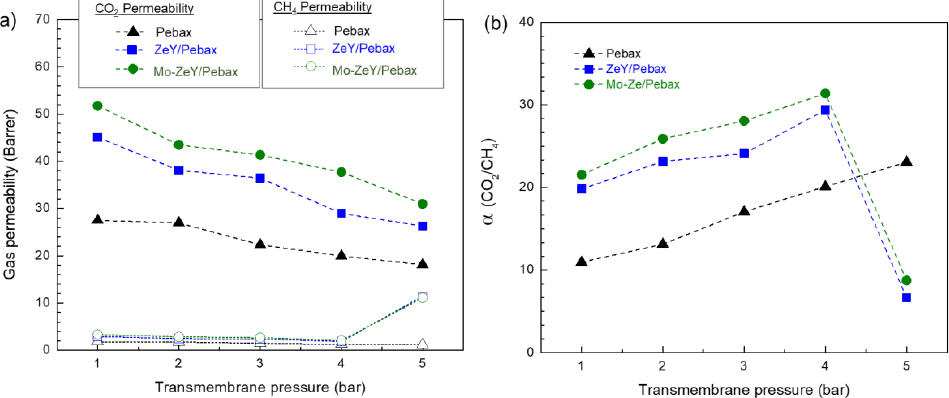
Figure 9. ( a ) Gas permeability and ( b ) CO 2 /CH 4 separation factor of neat Pebax, MMMs with 5 wt.% Figure 9. (a) Gas permeability and (b) CO 2 /CH 4 separation factor of neat Pebax, MMMs with 5 wt.% of ZeY and Mo- ZeY tested at 30 °C and 1 to 5 bar of transmembrane pressure.